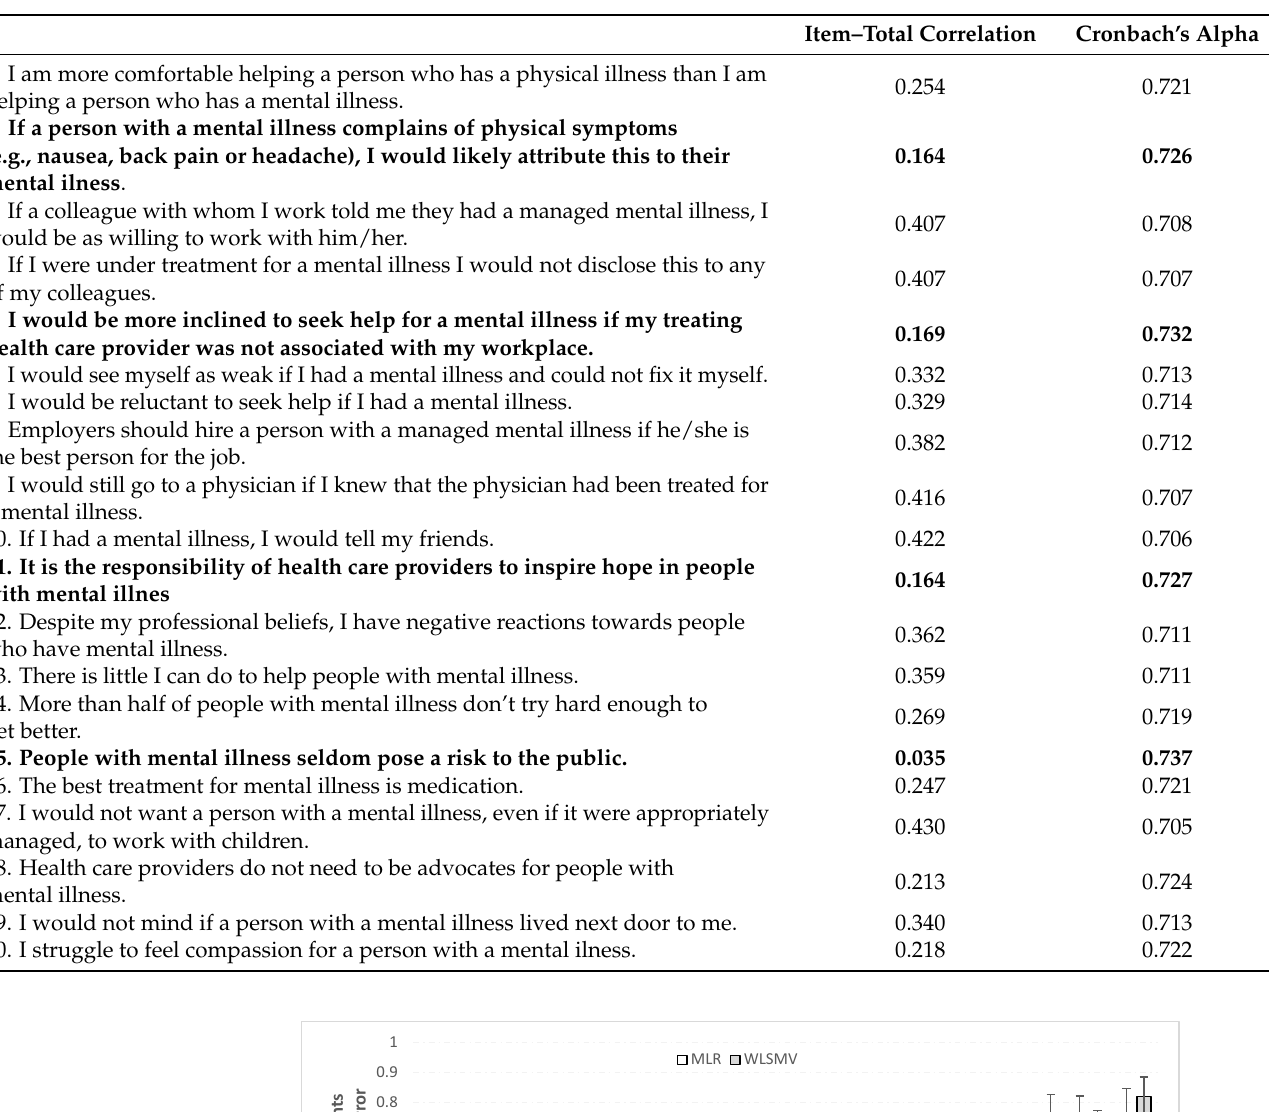
Table A1. List of the 20 items that started the analysis, correlation with the total scale and reliability as measured by Cronbach’s Alpha for the scale with each item removed. The Cronbach’s Alpha for the scale with all items was 0.723. In bold are the four items with low item–total correlation, which were removed from further analyses.